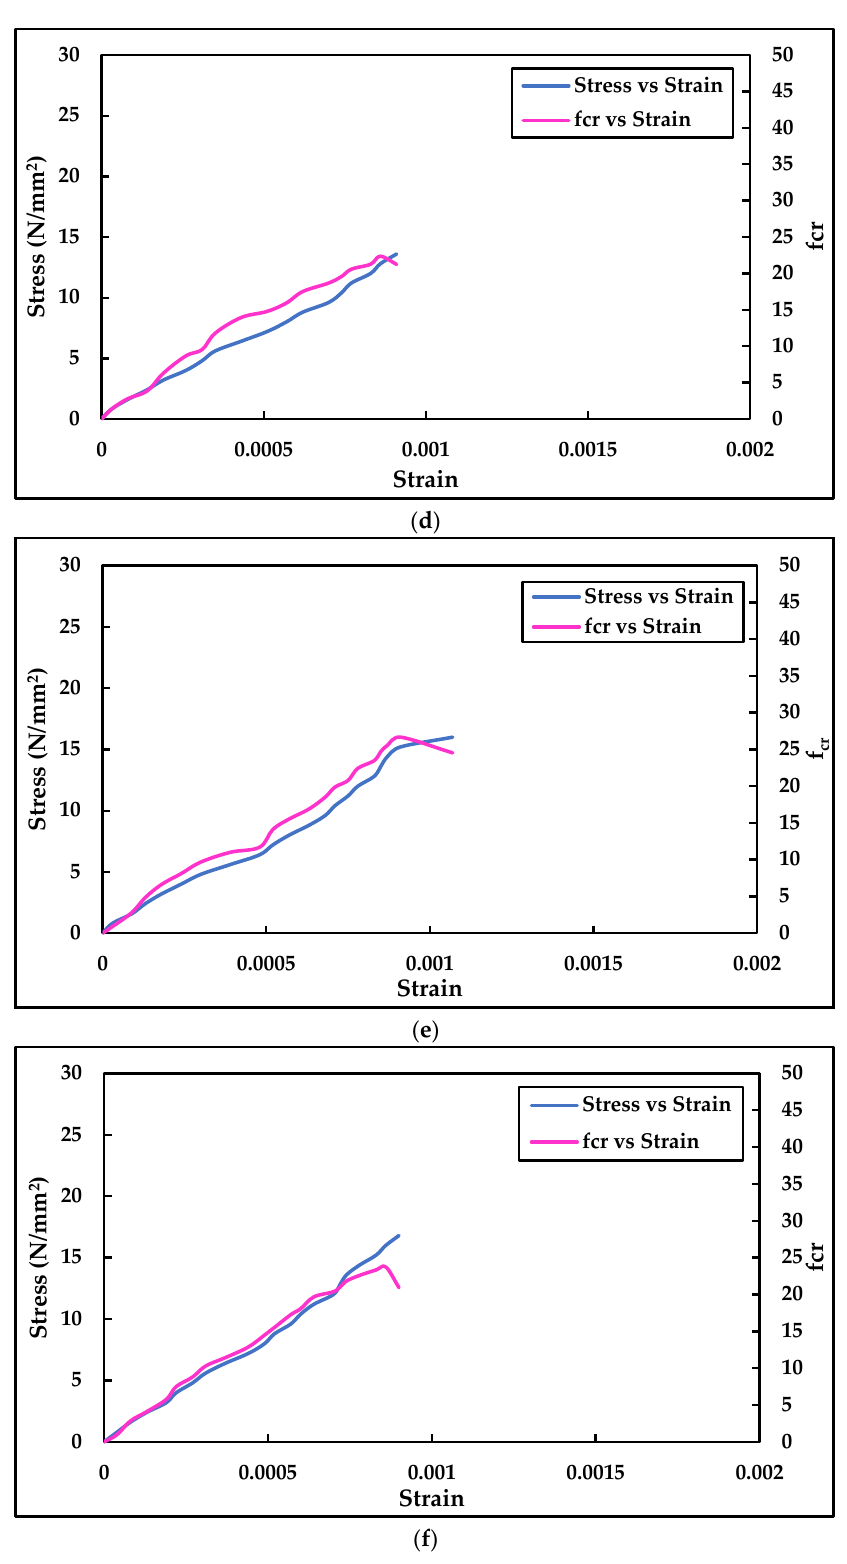
Figure 9. Graphical illustration of stress vs. strain and f cr vs. strain under 28 days of air curing. ( a ) Conventional mortar cube; ( b ) 0.10% brass fibre added mortar cube; ( c ) 0.15% brass fibre added mortar cube; ( d ) 0.20% brass fibre added mortar cube ( e ) 0.25% brass fibre added mortar cube; ( f ) 0.30% brass fibre added mortar cube.